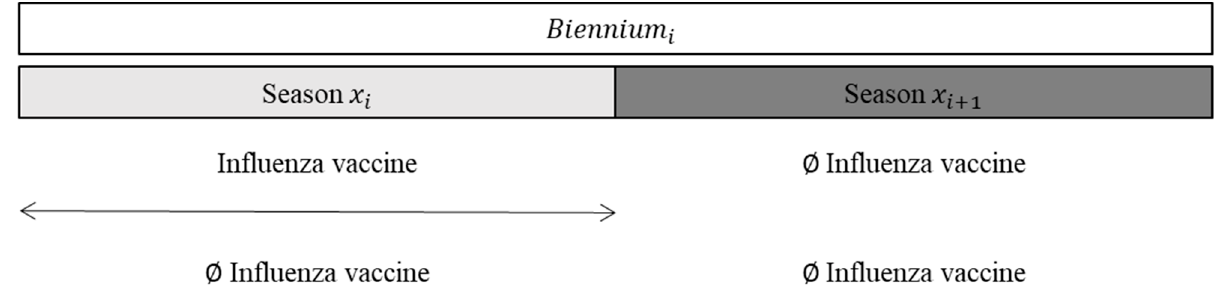
Figure 2. Definition of exposure to assess the prolonged effect of the influenza vaccine performed in a previous season on the following season. a previous season on the following